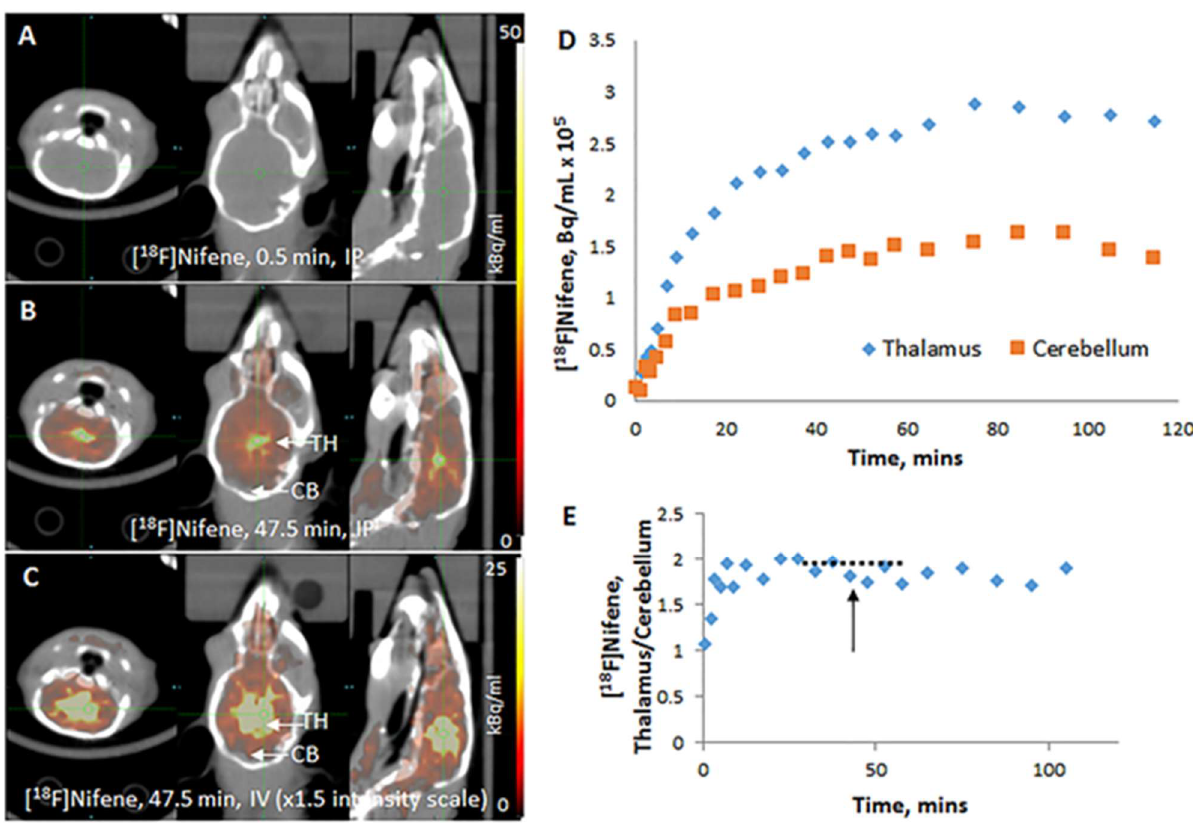
Figure 4. PET/CT of intraperitoneal (IP) [ 18 F]nifene (5.77 MBq in 50 mL saline) administered in wild-type mouse (BALB/c, female 24 g). ( A ) Coronal, transaxial, and sagittal images of mouse head at 0.5 min after injection showing no [ 18 F]nifene in the brain; ( B ) coronal, transaxial, and sagittal images of same mouse head at 47.5 min after injection; ( C ) PET intensity increased (×1.5) of images in ( B ) showing [ 18 F]nifene bound the thalamus and cortical regions; ( D ) time–activity curve of thalamus and cerebellum of region-of-interest shown on the sagittal slices; ( E ) ratio of thalamus to cerebellum of time–activity curve showing plateau between 30 to 60 min (dotted line).